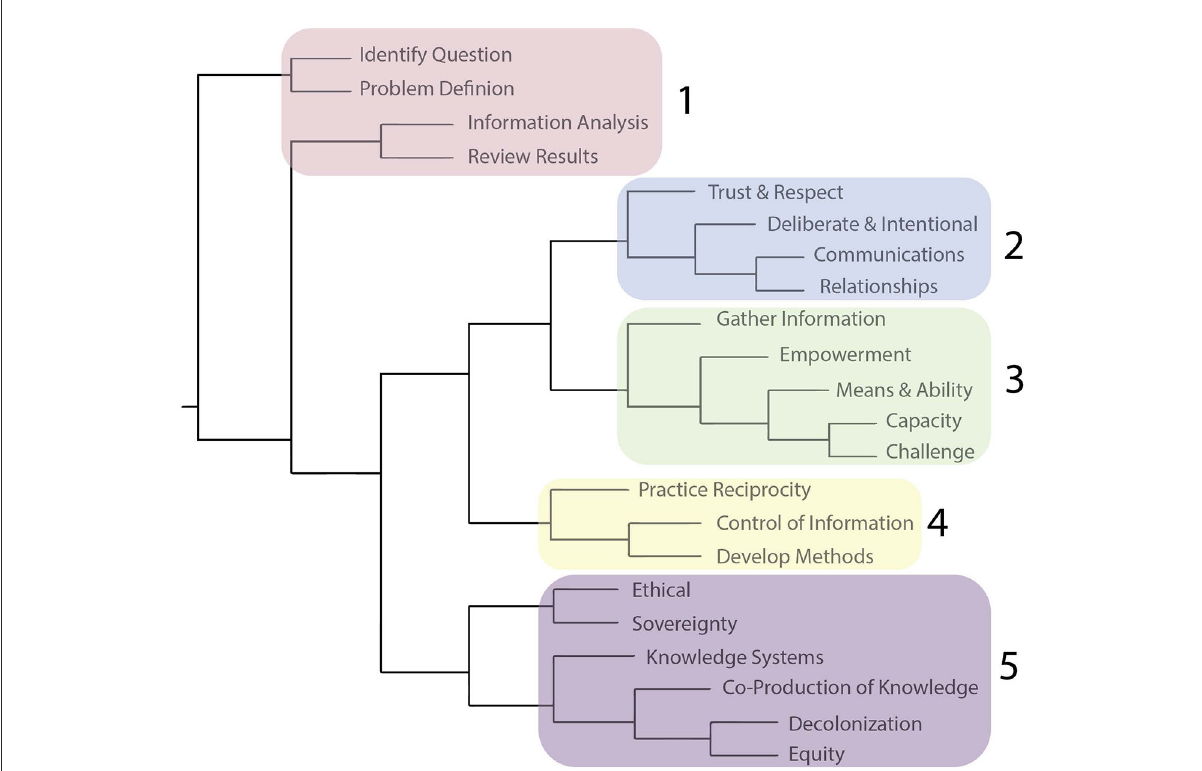
FIGURE5 Six clusters of codes based on similarity of words coded among them. The six clusters represent five meaningful groupings in the context of the Kake Climate Partnership project activities during this study. The clusters are displayed as branches in the above tree diagram, while the five meaningful themes are displayed using rounded transparent boxes, numbered 1-5. Each number corresponds to a meaningful group as follows: 1. Action Circle Basics; 2. Human Interactions; 3. Field Projects; 4. Partnership Operations; and 5. Big Ideas. Colors are used to differentiate clusters. Created by M. Rhodes-Reese in Adobe Illustrator, using NVivo software